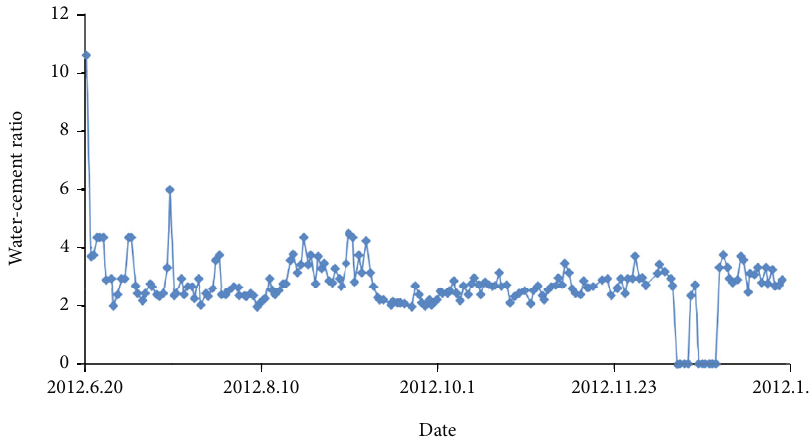
Figure 11: Water-cement ratio of